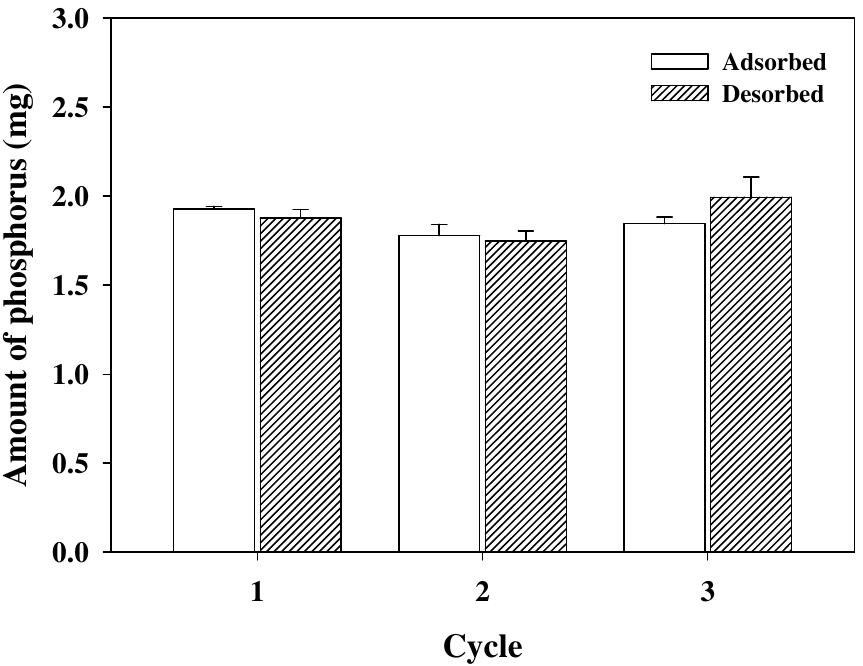
Figure 5. Reusability of PEI-PVC in three cycle applications (adsorbed phosphorus at pH 5 and desorbed in 1 M HCl solution).